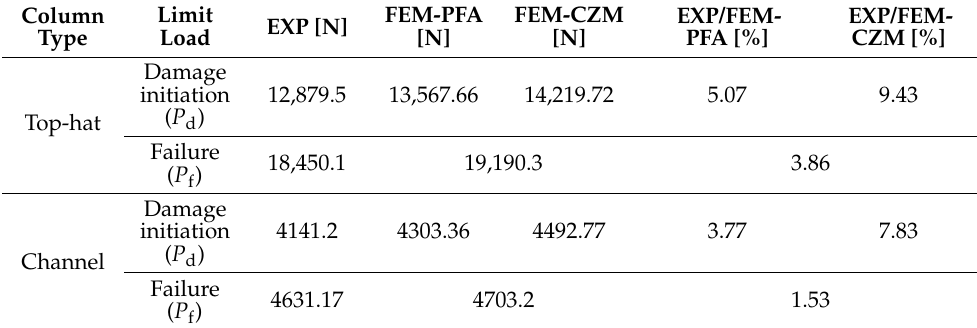
Table 3. Results of damage initiation and failure